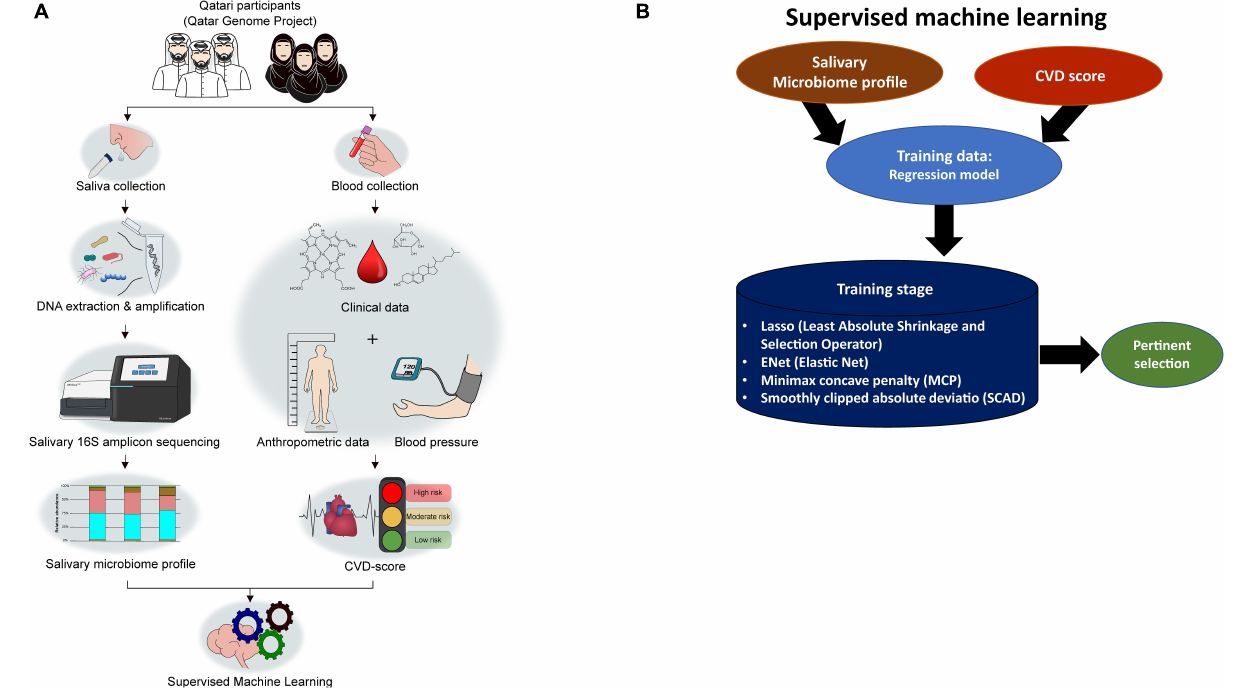
Frontiers in Microbiology |